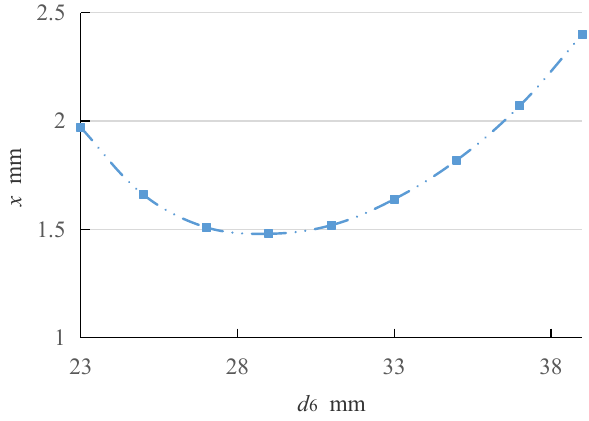
Figure 9. Relationship between d 6 and x.